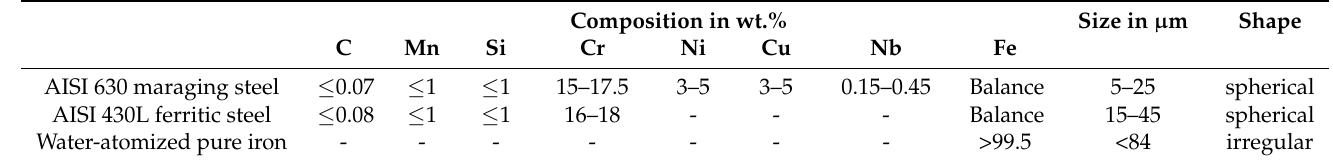
Table 2. Chemical compositions, sizes, and shapes of the steel powders in wt.%, according to the supplier